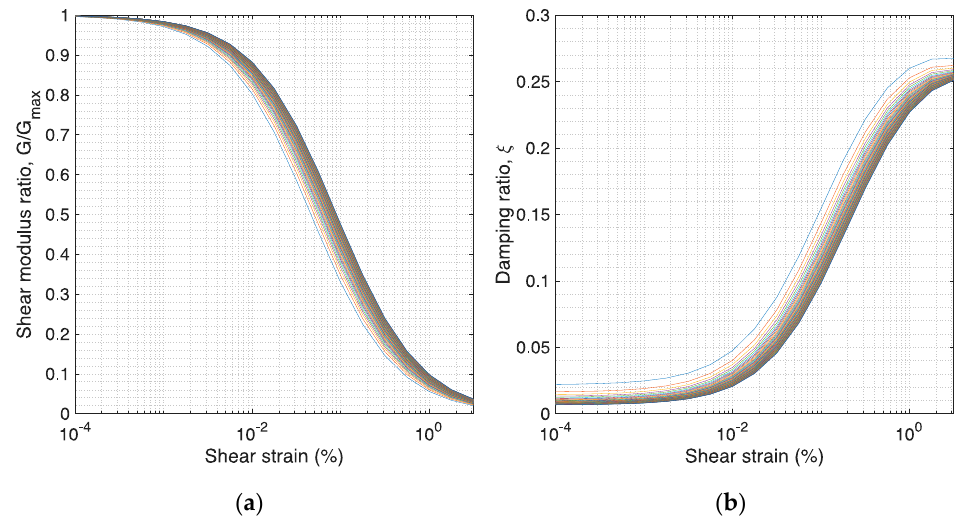
Figure 4. ( a ) Modulus reduction and ( b ) damping curves for the different layers of the academic soil profile.